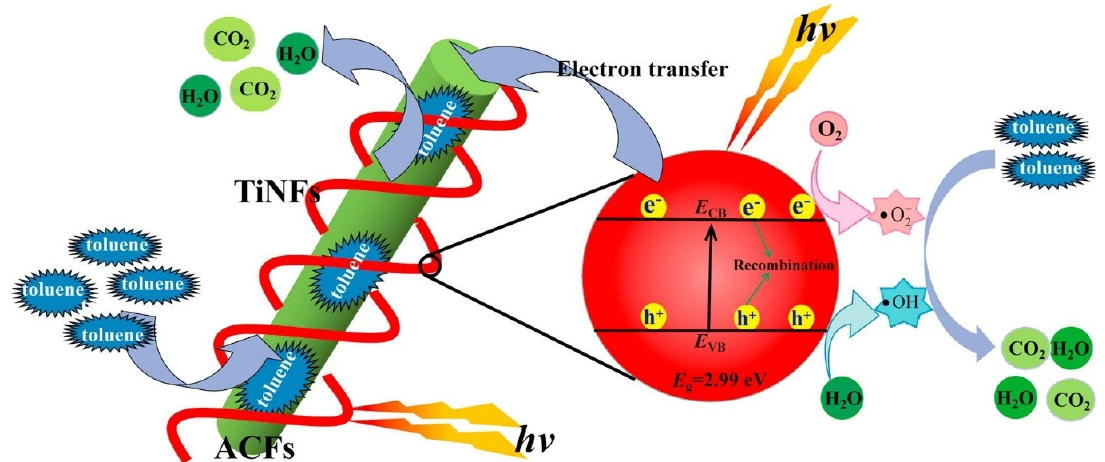
Figure 13. Scheme depicting the adsorption and photo-degradation synergetic model of TiO 2